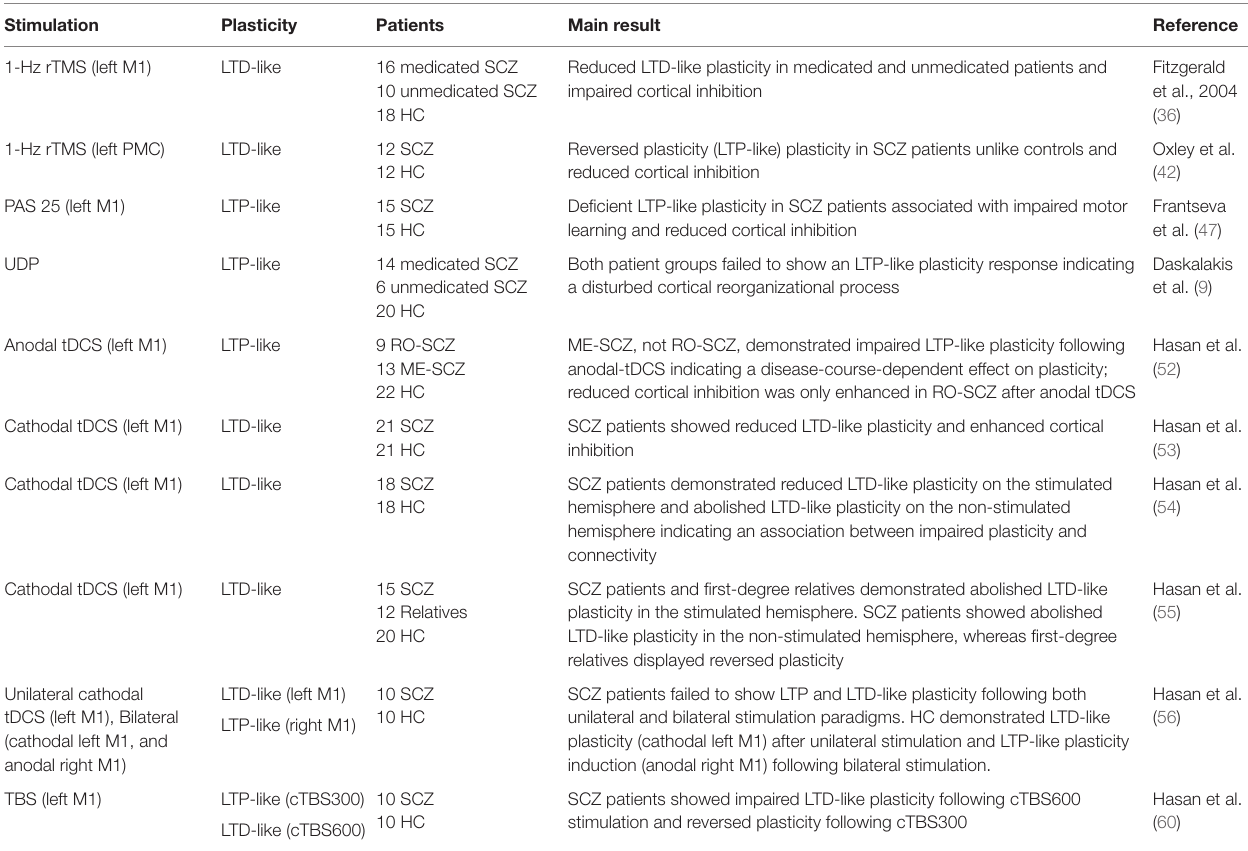
TABLe 1 | NiBS-induced cortical plasticity investigated in the motor cortex of SCZ